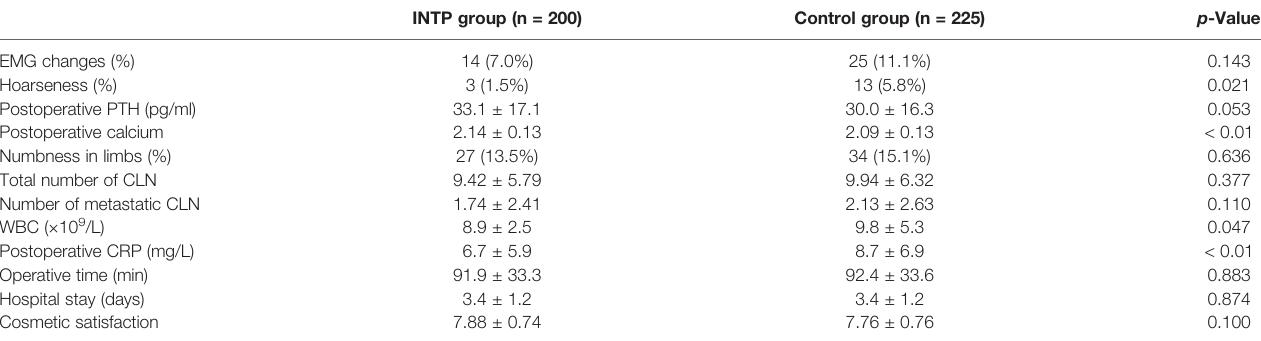
TABLE 6 | Effective assessment of INTP in transoral endoscopic